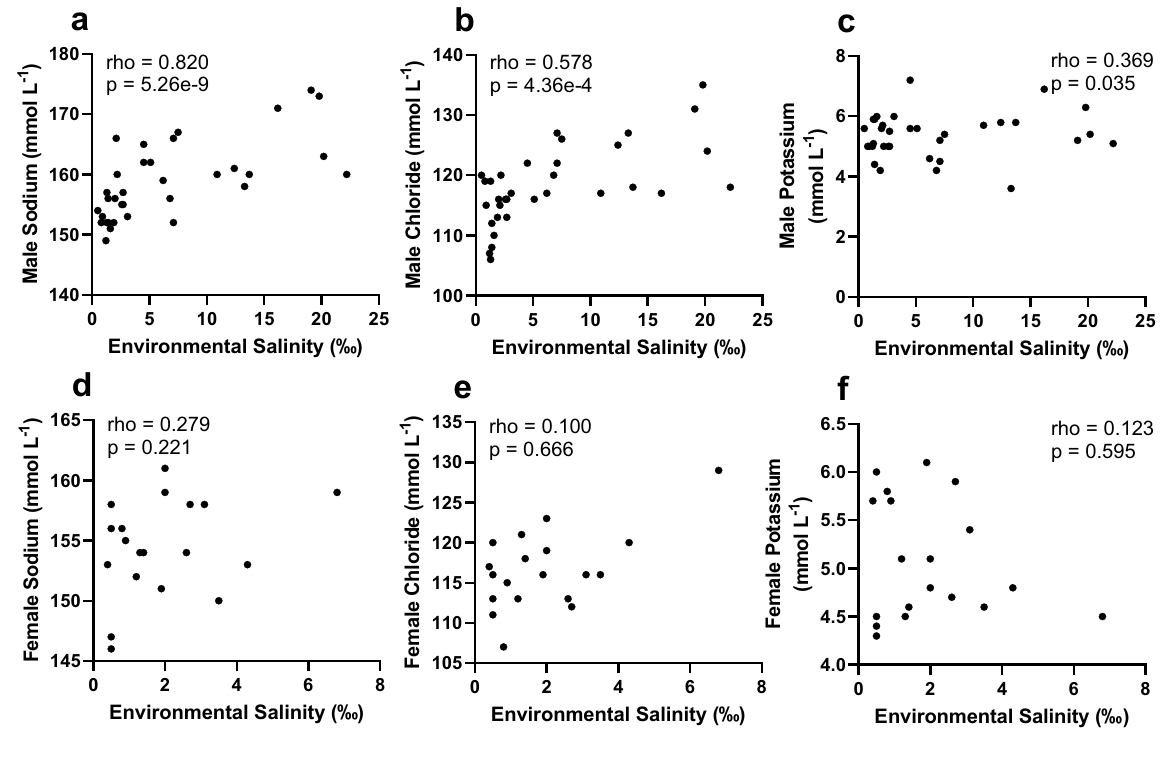
Figure 4. Spearman rank correlation between environmental salinity and plasma sodium ( a , d ), chloride ( b , e ), and potassium ( c , f ) in juvenile male and female American alligators ( Alligator mississippiensis ). rho Spearman’s rho, p significance of correlation.